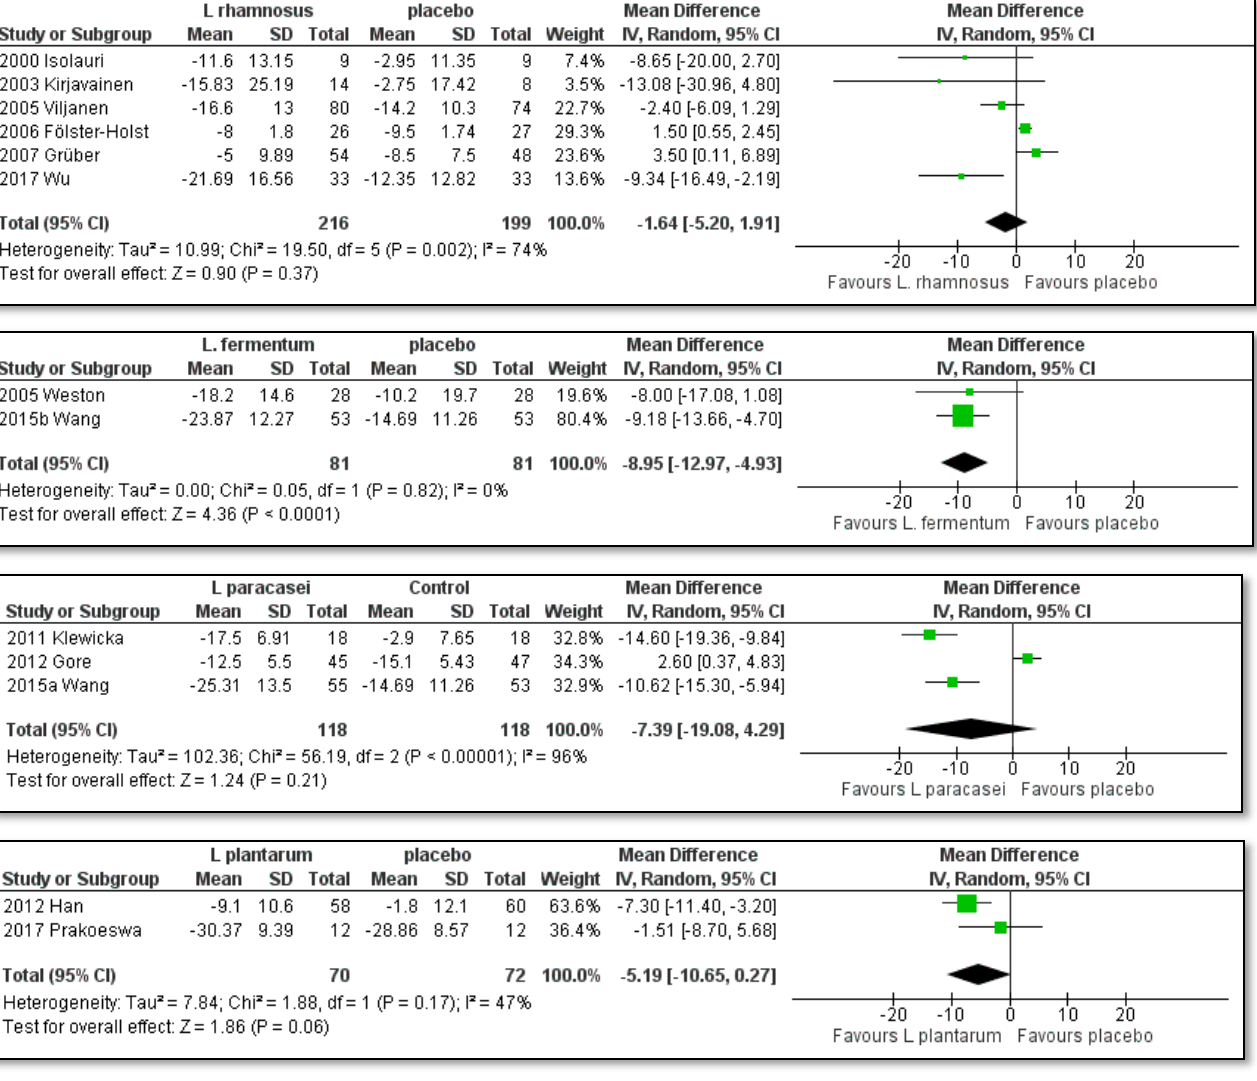
Figure 3. Subgroup meta-analyses of the e ff ect of the included single-strain probiotic Lacticaseibacil- lus rhamnosus , Limosilactobacillus fermentum , Lacticaseibacillus paracasei and Lactiplantibacillus planta- rum strains compared to placebo on the SCORAD index change in children with AD [41–44,46,47,49– 54].